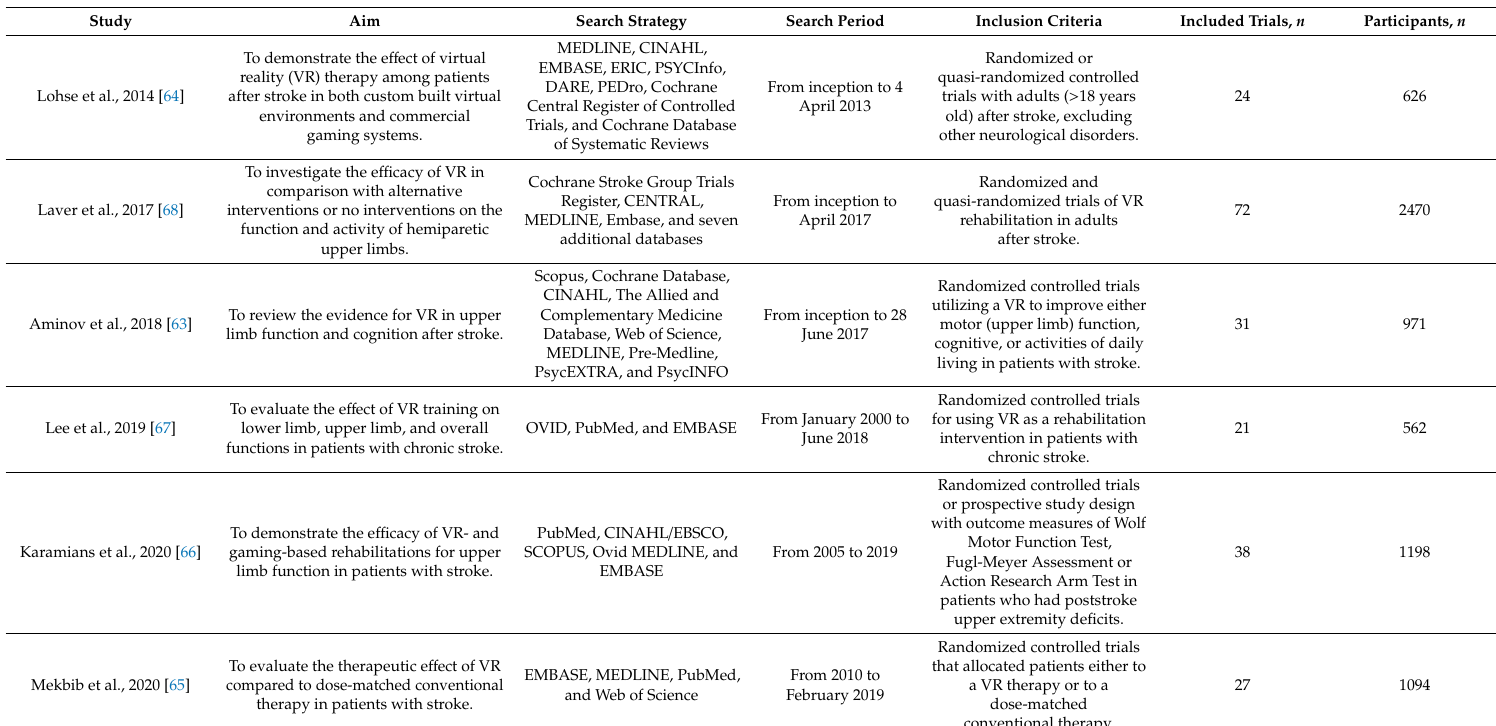
Table 3. Characteristics of the included